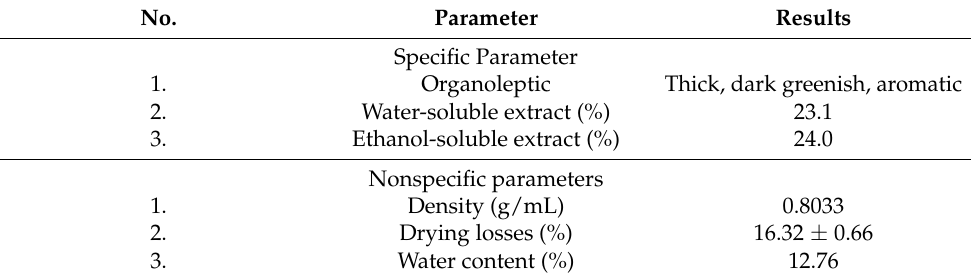
Table 1. Specific and non-specific parameters of Calophyllum soulattri leaves